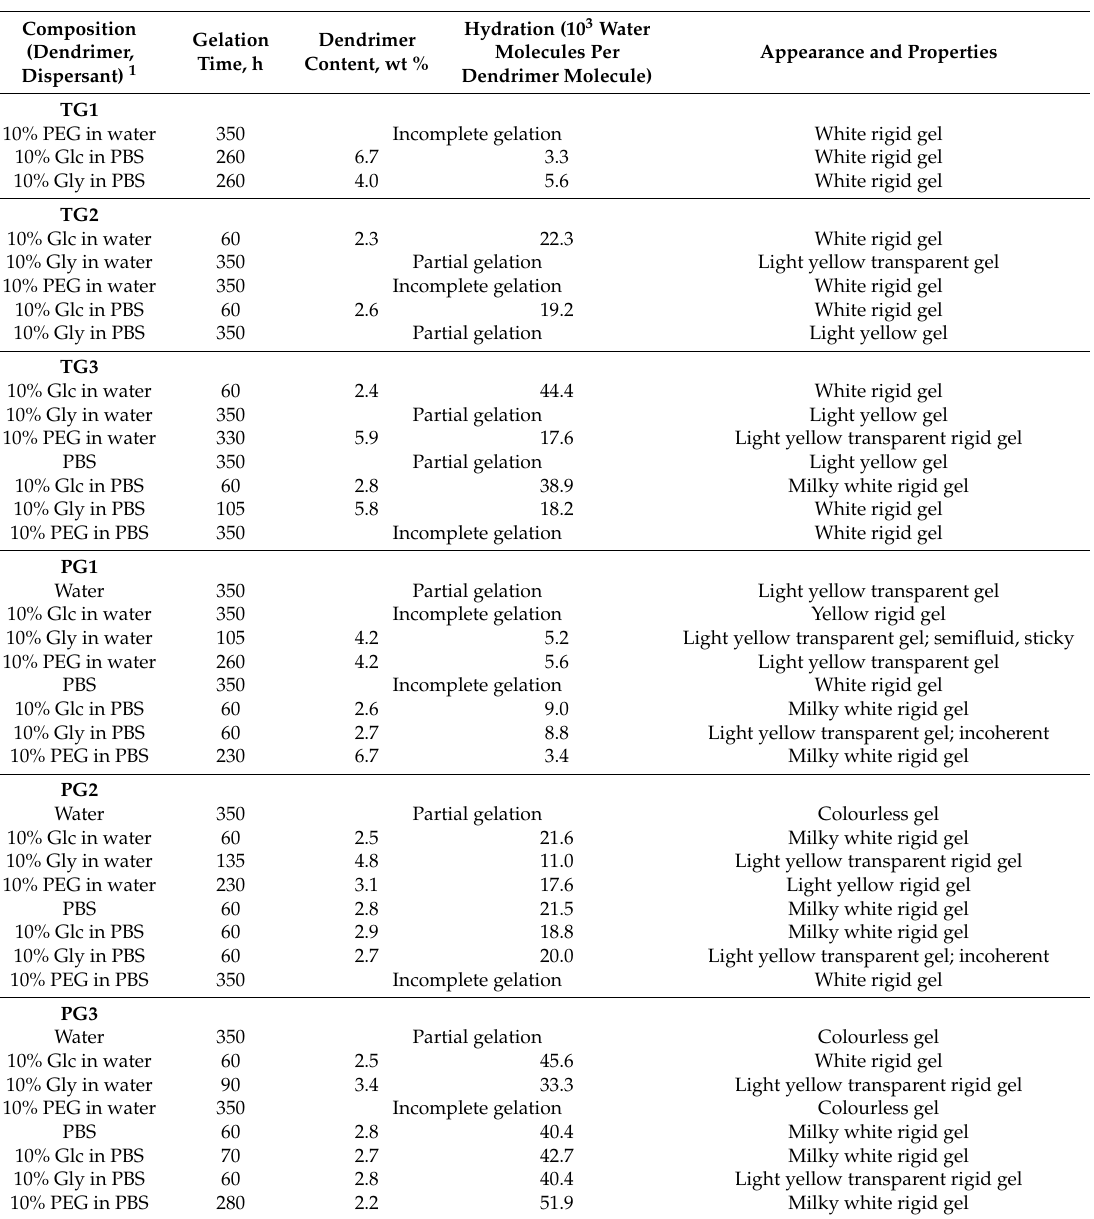
Table 1. Properties of dendrimer